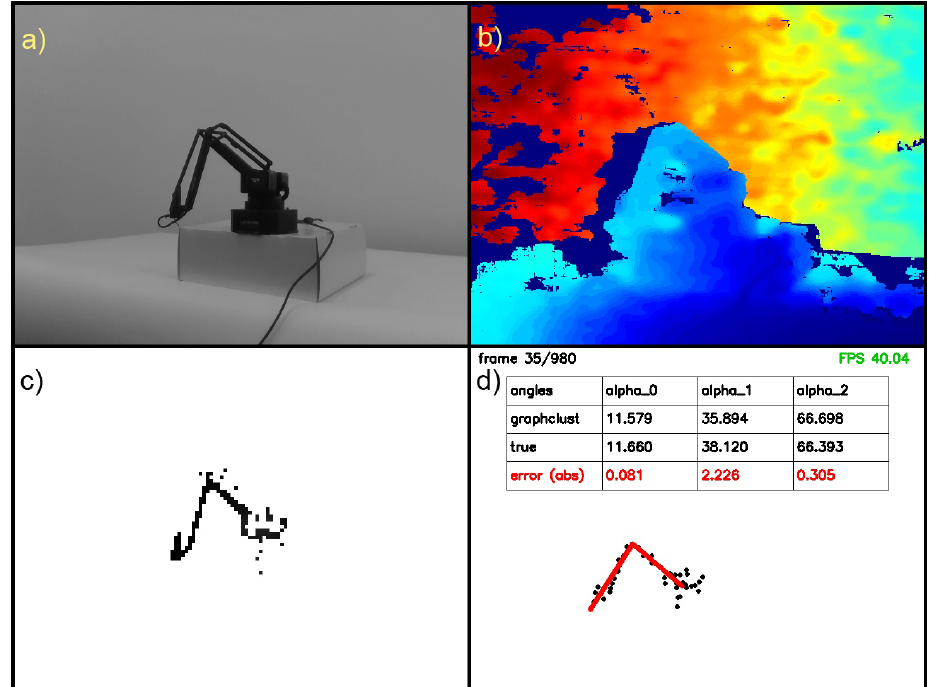
Figure 4. Preprocessing steps: ( a ) input RGB image, ( b ) input depth image, ( c ) image after removing the static background and ( d ) results after transformation to point cloud, k -means (black dots) and the result of graph fitting (red